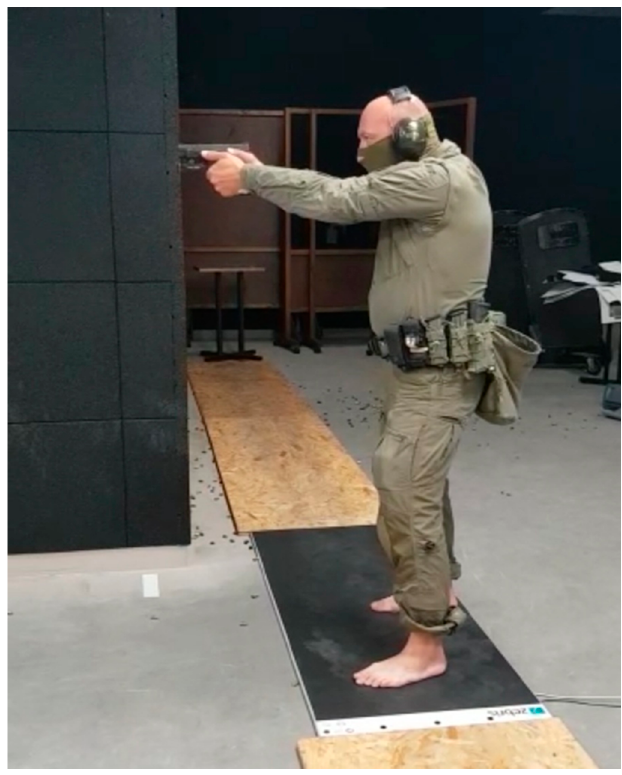
Figure 1. Basic equipment and shooting position.